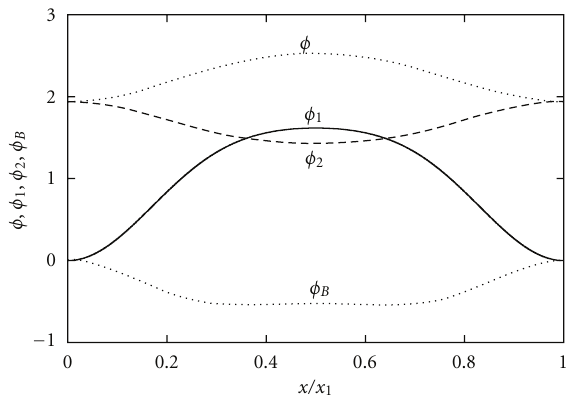
Figure 5: The components of the electrostatic potential Φ plotted along the x -direction. The parameter values used for the figure are t = 0 . 5, magnetic induction parameter b = 0 . 5, and GL parameters κ = 72 and β sd = 0.